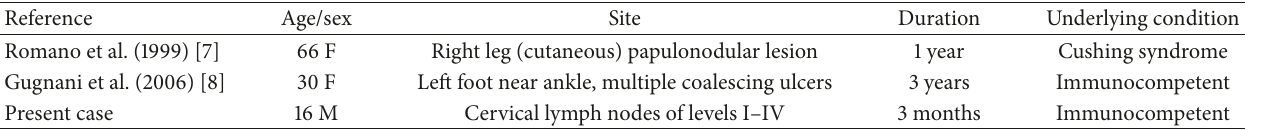
Table 1: Cases reported in the literature.